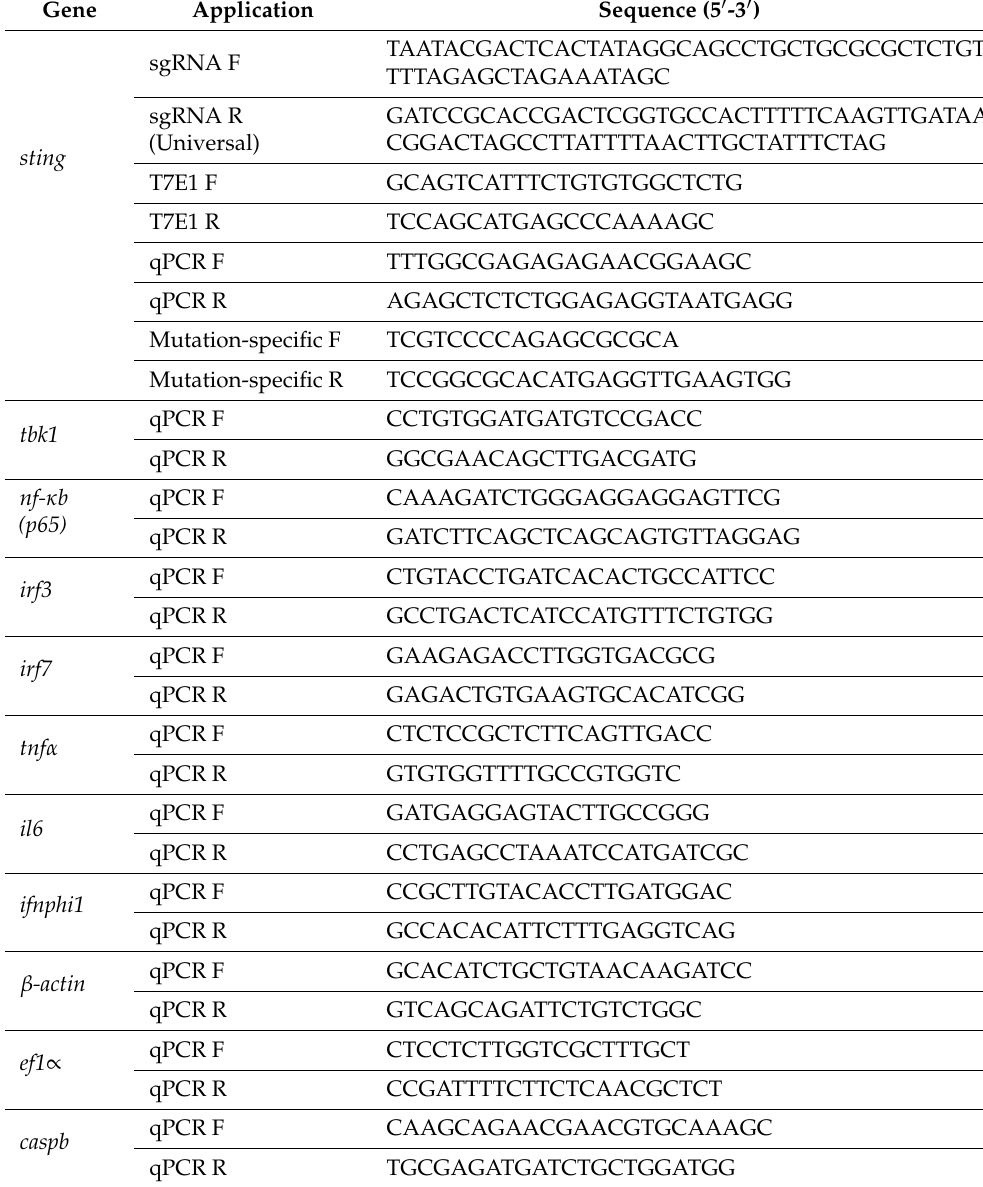
Table 1. The primers used in this